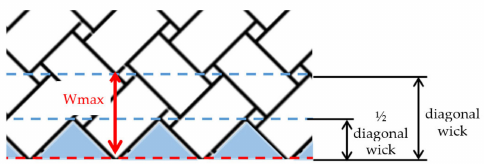
Figure 8. Theoretical maximum value of Wb in 45 ◦ fiber orientation